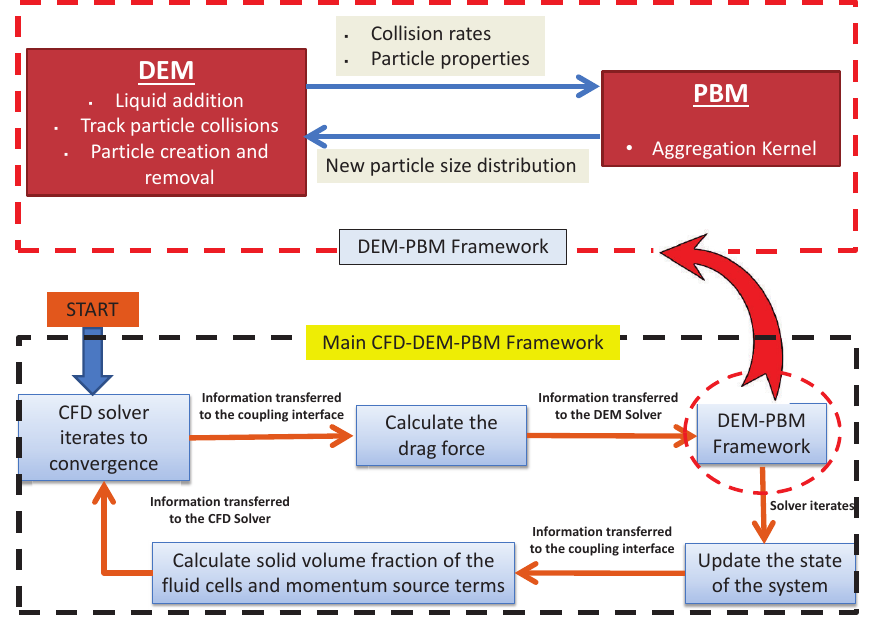
Figure 1. Schematic of the coupled multi-scale